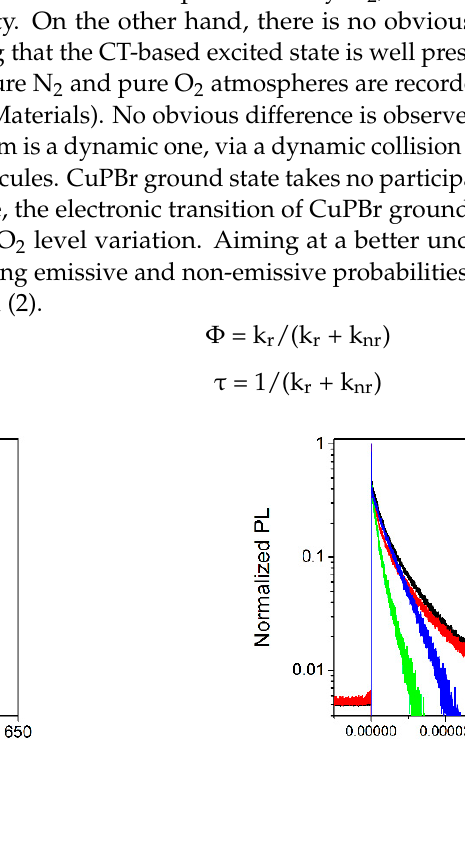
Figure 9. Emission spectra ( a ) of CuPX with excitation wavelength of 350 nm under pure N 2 and pure O 2 . Emission decay dynamics of ( b ) of CuPX with excitation wavelength of 355 nm under pure N 2 and pure O 2 , X = Br, Cl.